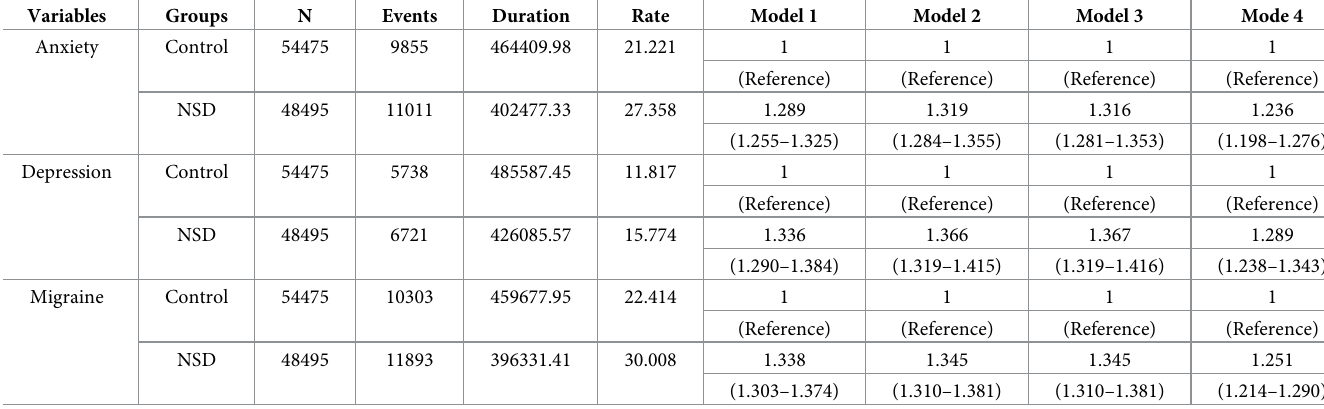
Comparison of incidence of depression between the NSD and control groups Depression was more frequent in the NSD group than in the control group (Table 3). In addi- tion, the Kaplan–Meier curve of the NSD group showed a higher incidence of depression over time than that of the control group (Fig 2). This outcome was also shown in adjusted models (models 2, 3, and 4). The incidence rates of depression were 11.817 and 15.774 per 1000 Table 3. Crude and adjusted hazard ratios of NSD for anxiety, depression, and